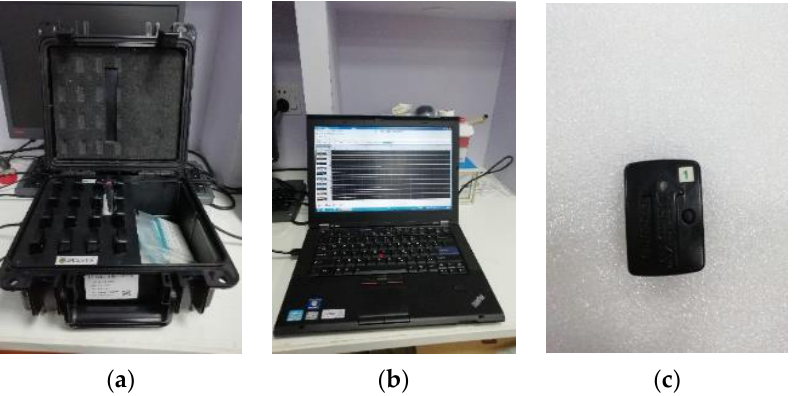
Figure 1. sEMG collection device, ( a ) TrignoTM Wireless EMG System; ( b ) operation community of Delsys software; ( c ) sEMG sensor.